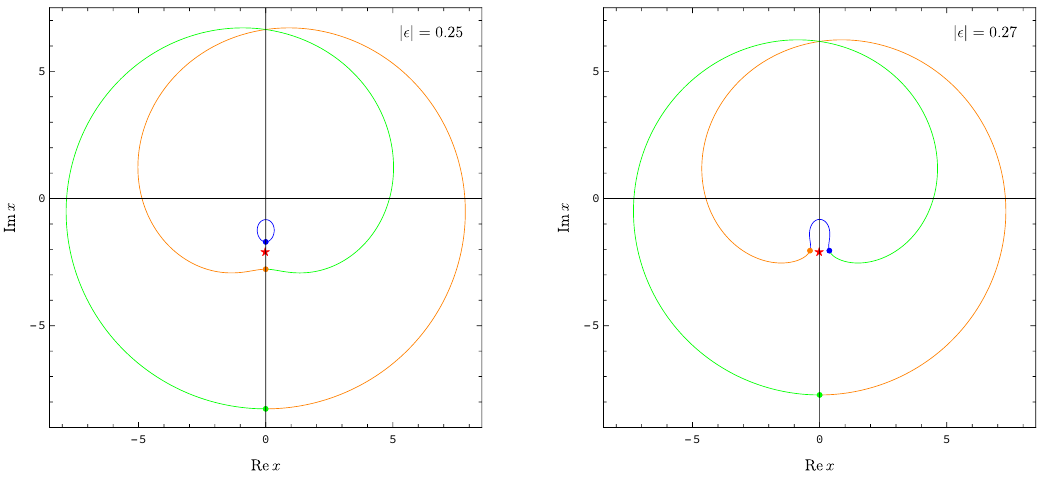
Figure 18 . The two closest to the origin solutions x 0 and x 1 to eq. (5.10) in the complex x -plane as functions of the complexified parameter (cid:15) = −| (cid:15) | e iϕ , where ϕ ∈ [0 , 2 π ] for | (cid:15) | = 0 . 25 (left panel) and | (cid:15) | = 0 . 27 (right panel). Coloured dots correspond to ϕ = 0 . The critical point setting the radius of convergence of the series (5.11) is located at x ≈ − 2 . 1176 i (it is shown by the red